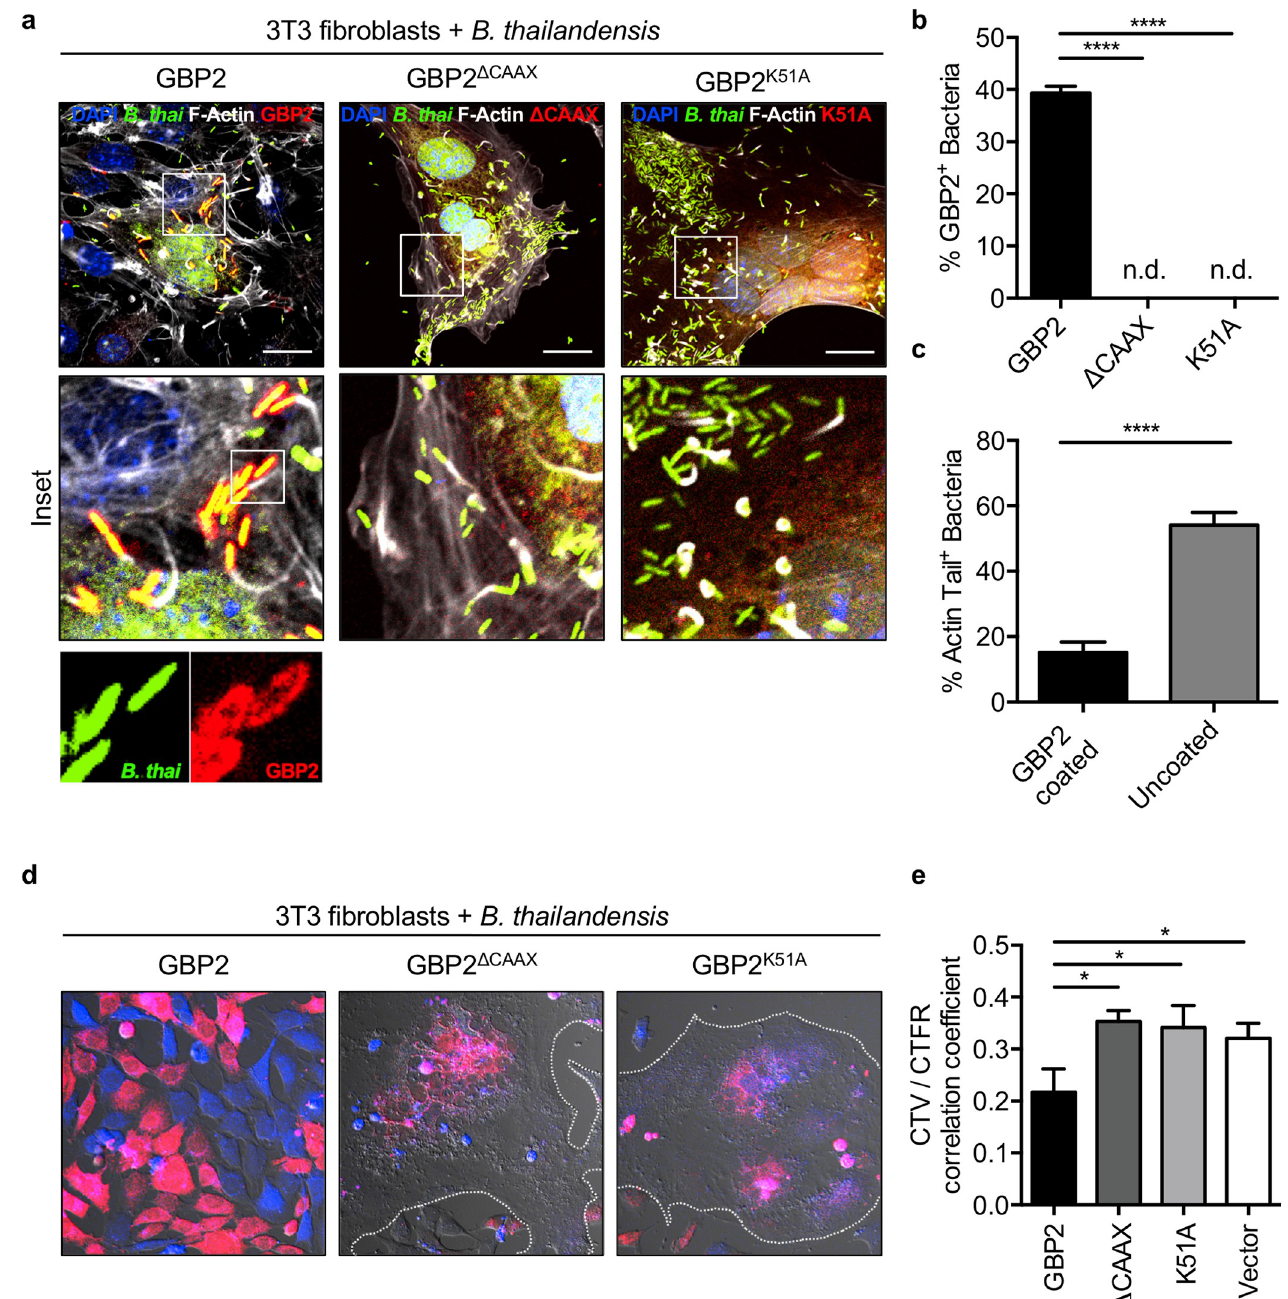
Fig 4. GBP2 activity requires GTPase and CAAX domains to restrict B . thailandensis . NIH3T3 fibroblasts stably transduced with mCherry-tagged GBP2 (wildtype and mutants, red) and unprimed cells were infected with B . thailandensis (GFP + ). ( a-c ) Cells were fixed at 12 h post-infection, stained for F-actin (white), and images were collected for GBP2 localization and F-actin tail quantification. NIH3T3 fibroblasts pre-stained with CellTrace Far Red or CellTrace Violet and seeded overnight at a 1:1 ratio ( d ) were fixed at 24 h post-infection and imaged for cell fusion and ( e ) had fusion quantified by colocalization of the two CellTrace signals. Dotted white line outlines the boundary of large MNGC formed during infection. Images are representative of at least ten images collected for quantification. White scale bars indicate 20 μ m. Significance was determined by one-way ANOVA with the Holm-Sidak multiple comparison test, � P < 0.05, ���� P < 0.0001 ( b, c, e ).